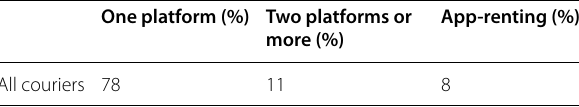
Table 3 Number of platforms by courier and practice of app- renting. Source : Author’s